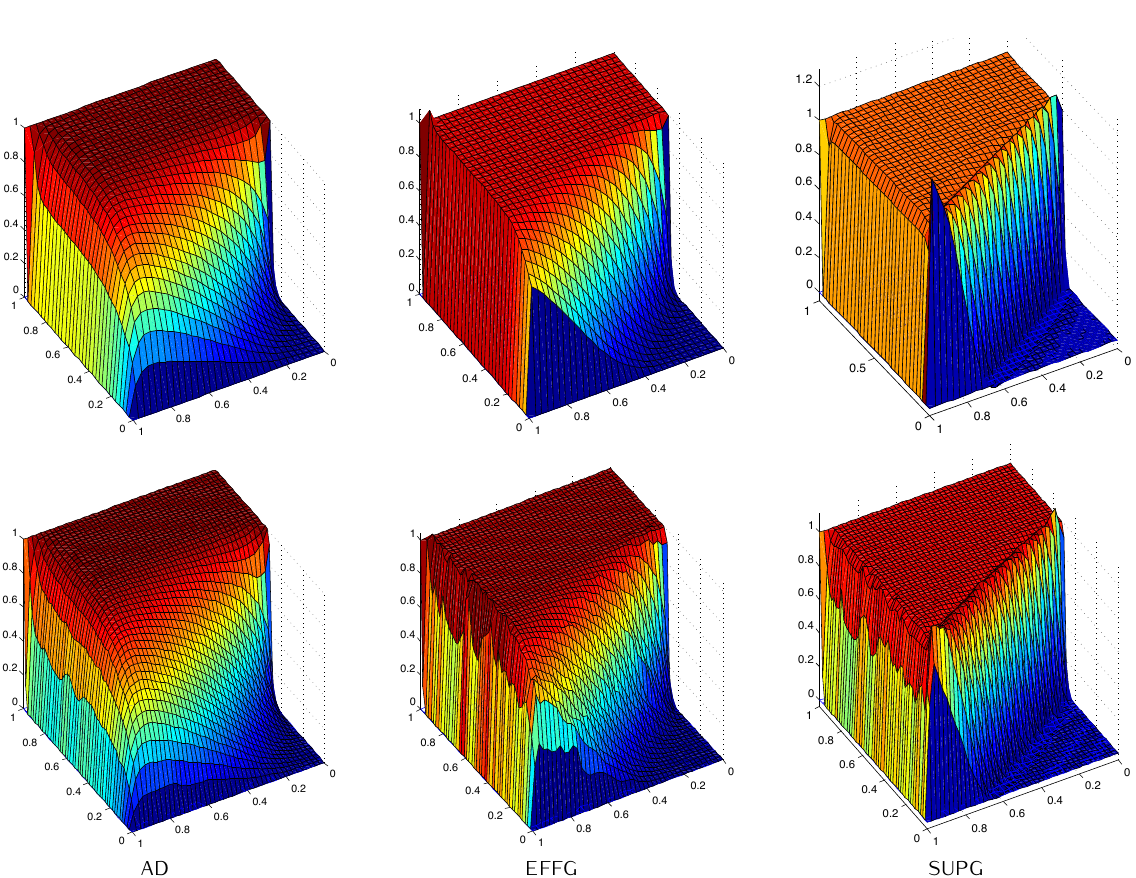
Figure 5. Surface plots of the solution of the skew advection test problem (30) with ε on 33 × 33 grids. Top row: uniform grid. Bottom row: randomly perturbed grid.